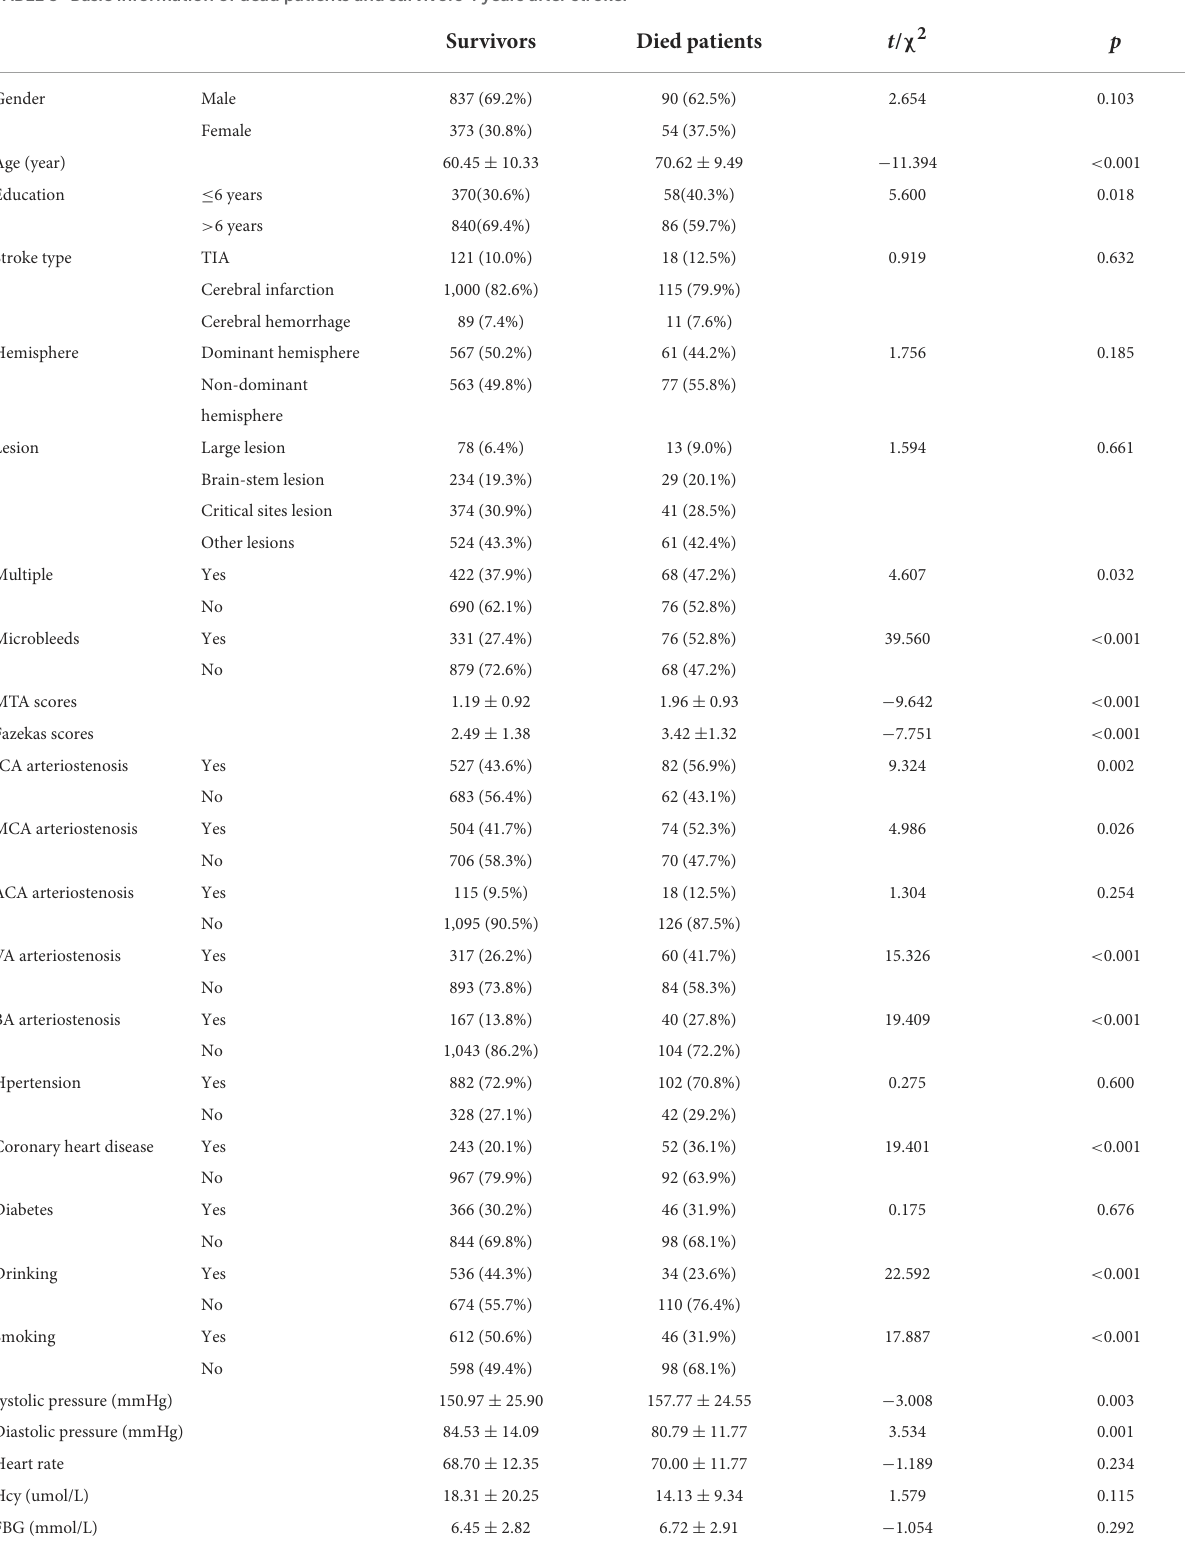
TABLE 5 Basic information of dead patients and survivors 4 years after stroke.